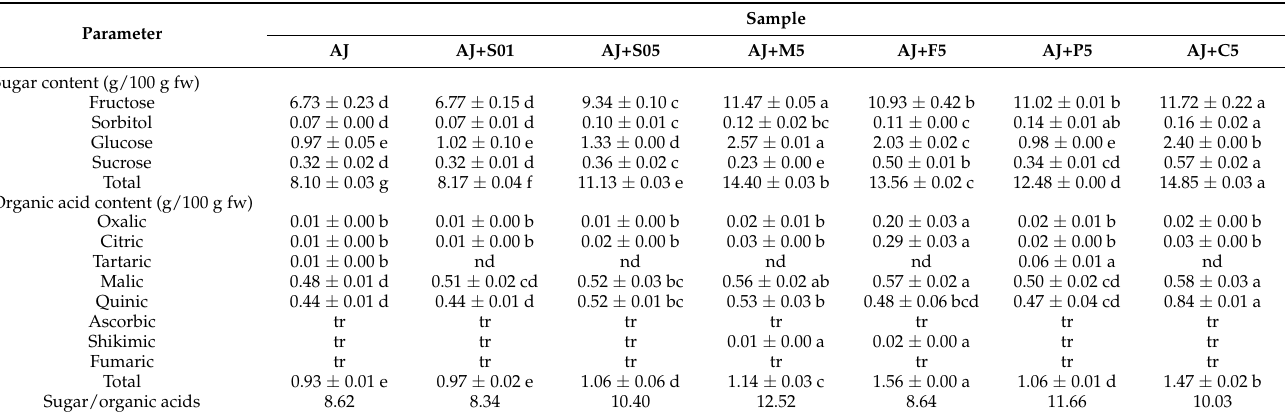
Table 2. Sugar and organic acid content in apple juice and enriched apple